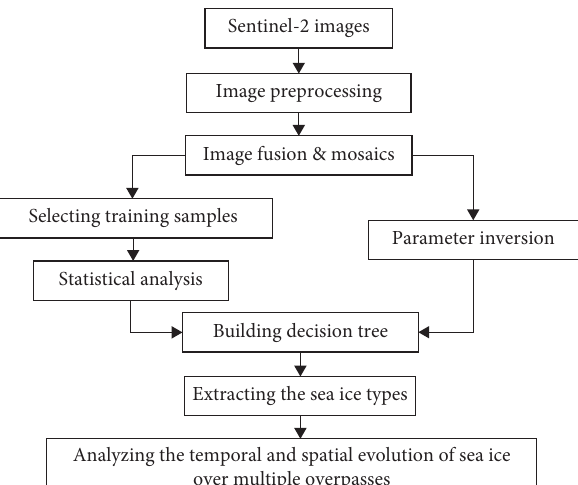
Figure 3: Methodology workflow proposed in this paper used for monitoring the growth and development of sea ice in Liaodong